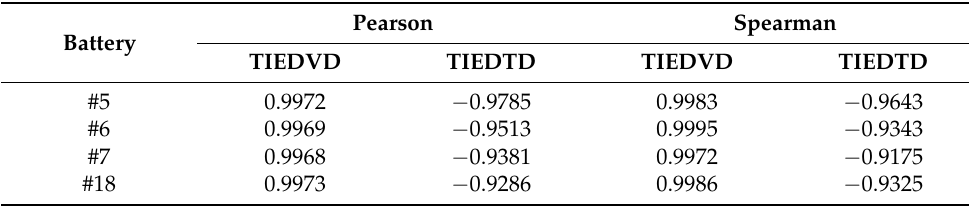
Table 1. Correlation Analysis between HIs and